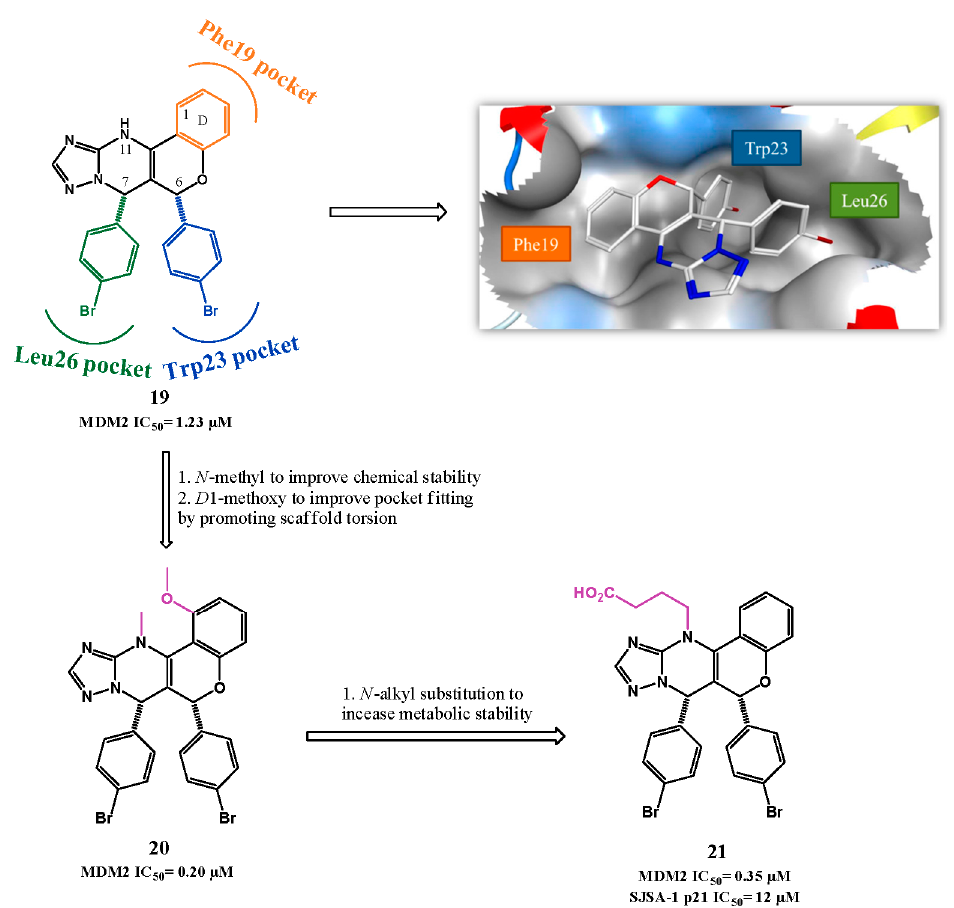
Figure 7. Chromenotriazolopyrimidine scaffold optimization. Right upper quadrant: crystal structure of compound 19 bound to MDM2 (PDB 3JZK). MDM2 surface is colored in blue for hydrophilic areas and grey for hydrophobic areas. Compound 19 is depicted as a stick model and is colored according to element type: white for carbon atoms, blue for the nitrogen atom, red for the oxygen atom, and dark red for bromine atoms.